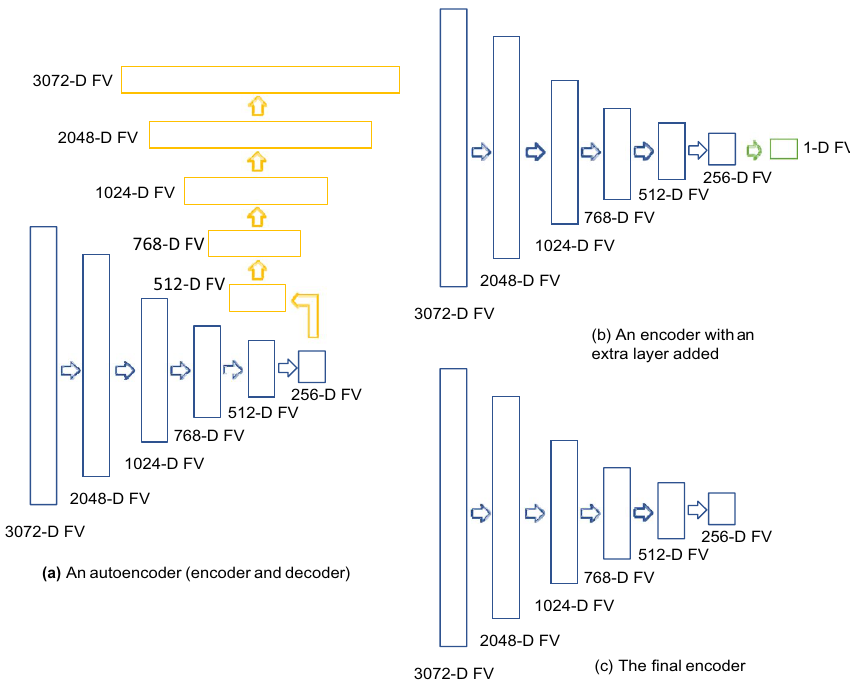
Figure 4. An overview of autoencoder topologies: ( a ) an autoencoder, with an encoder (highlighted in blue) and an decoder (highlighted in yellow), is constructed during step 1: Unsupervised end-to-end training with decoder, ( b ) an encoder (highlighted in blue) with an extra layer added (highlighted in green) is constructed during step 2: supervised fine-tuning with labels, ( c ) an encoder (highlighted in blue) is constructed by removing the 1-dimension